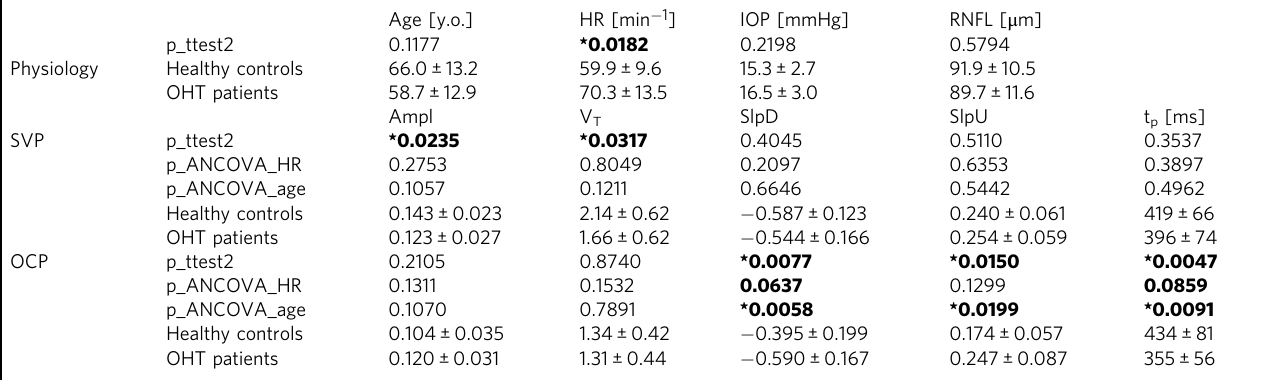
Table 1 Participant characteristics and morphology measurements of retinal pulsatile patterns. Age